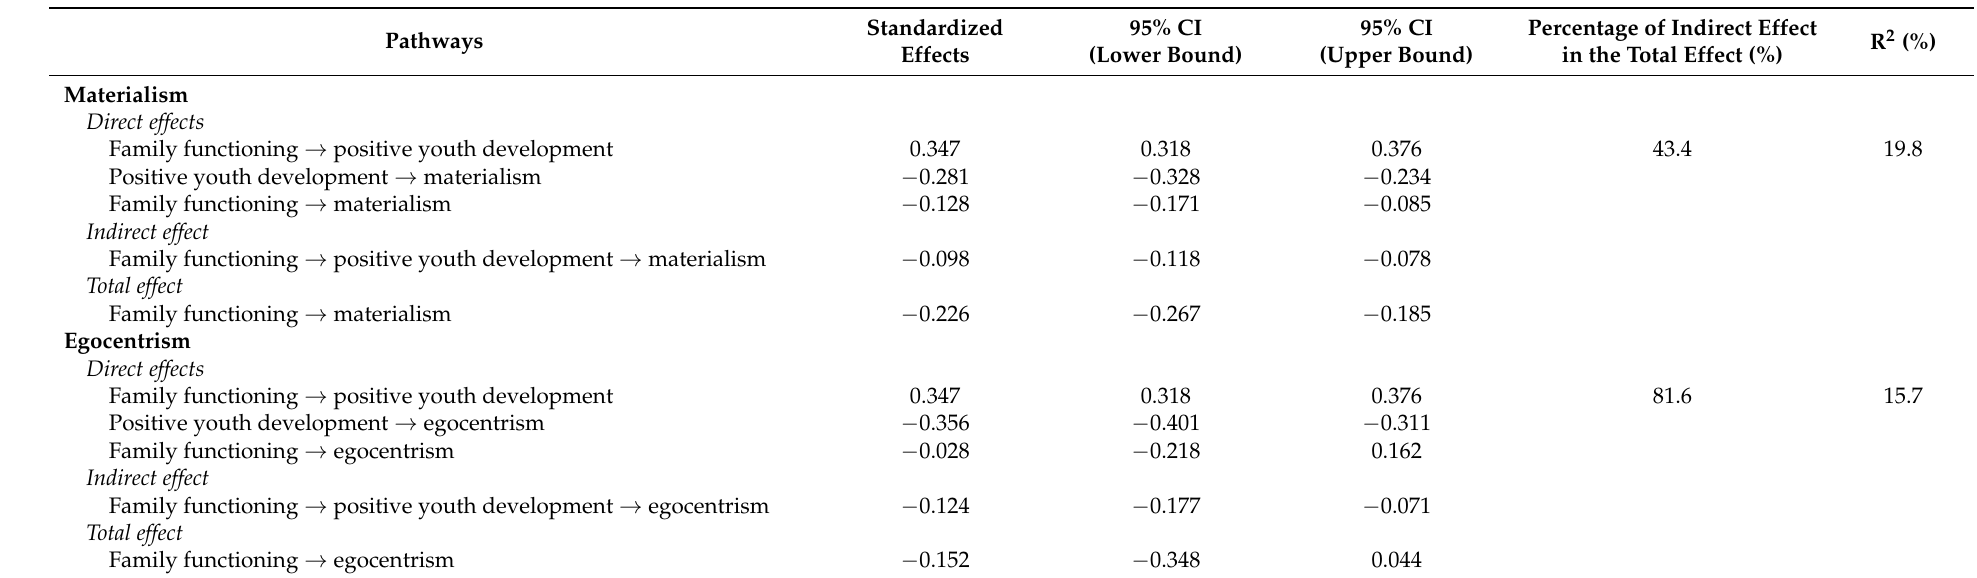
Table 2. Results of mediation analyses with controlling for age and sex ( n =